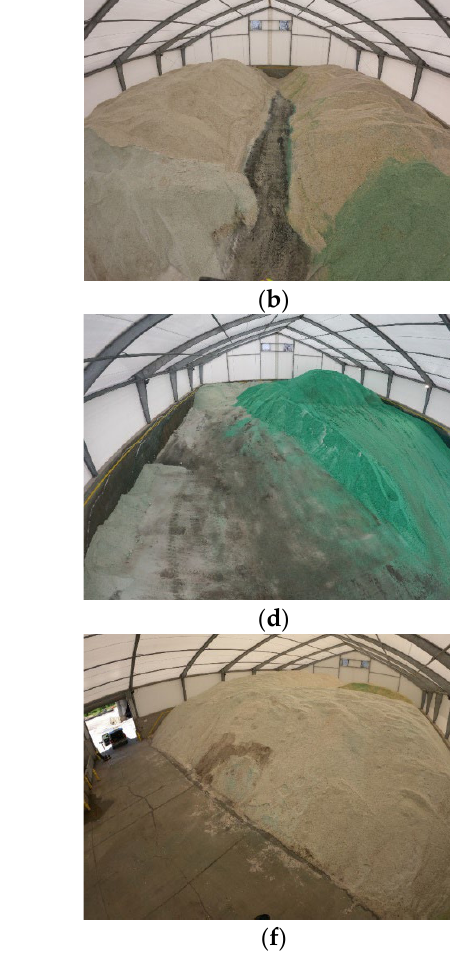
Figure 8. GoPro Images of corresponding Lebanon salt piles for the 2021–2022 winter season ( a ) 23 November 2021, GoPro Image ( b ) 6 January 2022, GoPro Image ( c ) 26 January 2022, GoPro Image ( d ) 11 February 2022, GoPro Image ( e ) 31 March 2022, GoPro Image ( f ) 23 May 2022, GoPro Image.